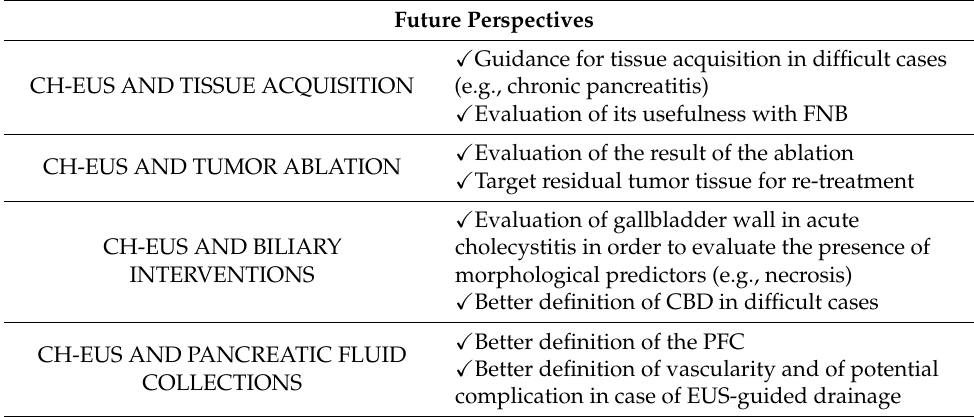
Table 1. Future perspective